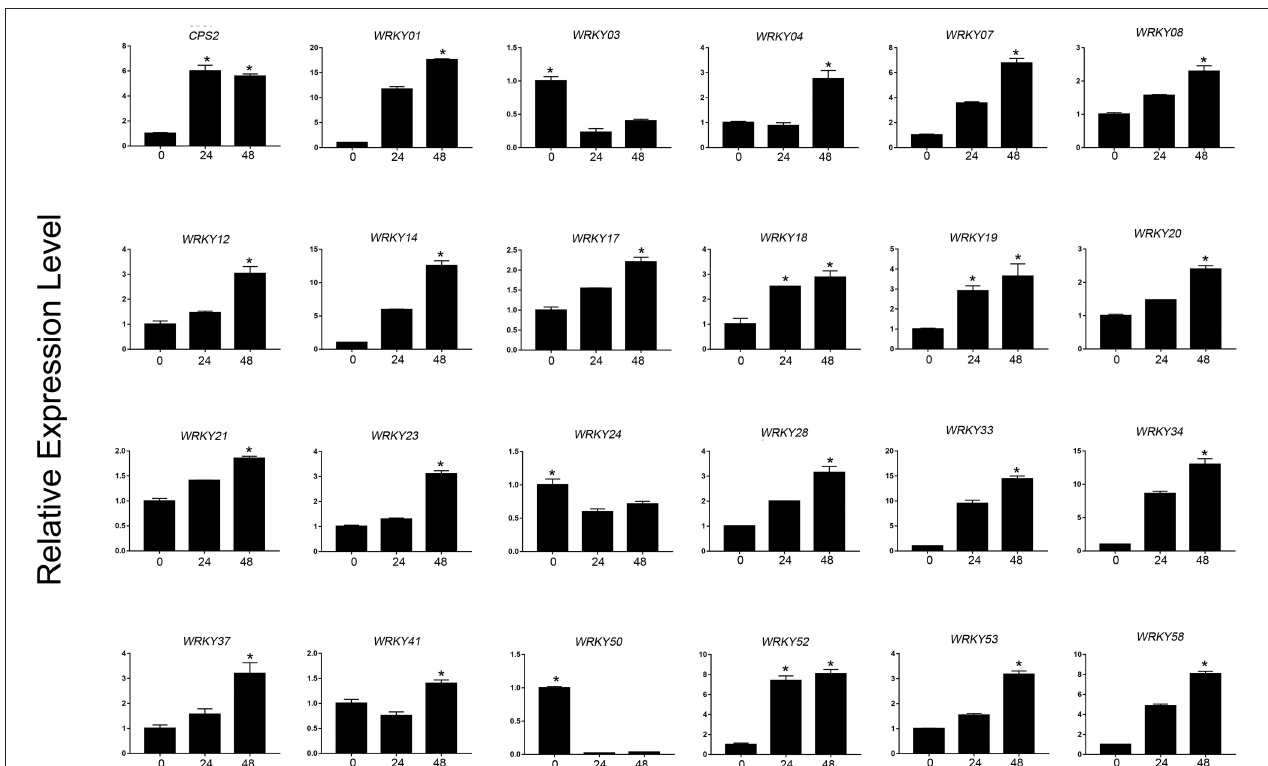
FIGURE 9 | qRT-PCR analysis of ApWRKYs with putative roles in andrographolide biosynthesis in MeJA-treated seedlings (MeJA-24 and MeJA-48, respectively) in A. paniculata . The actin gene was tested as an internal reference. CPS2 was used as the positive control. The asterisks (*) represent significant differences ( P < 0.05).